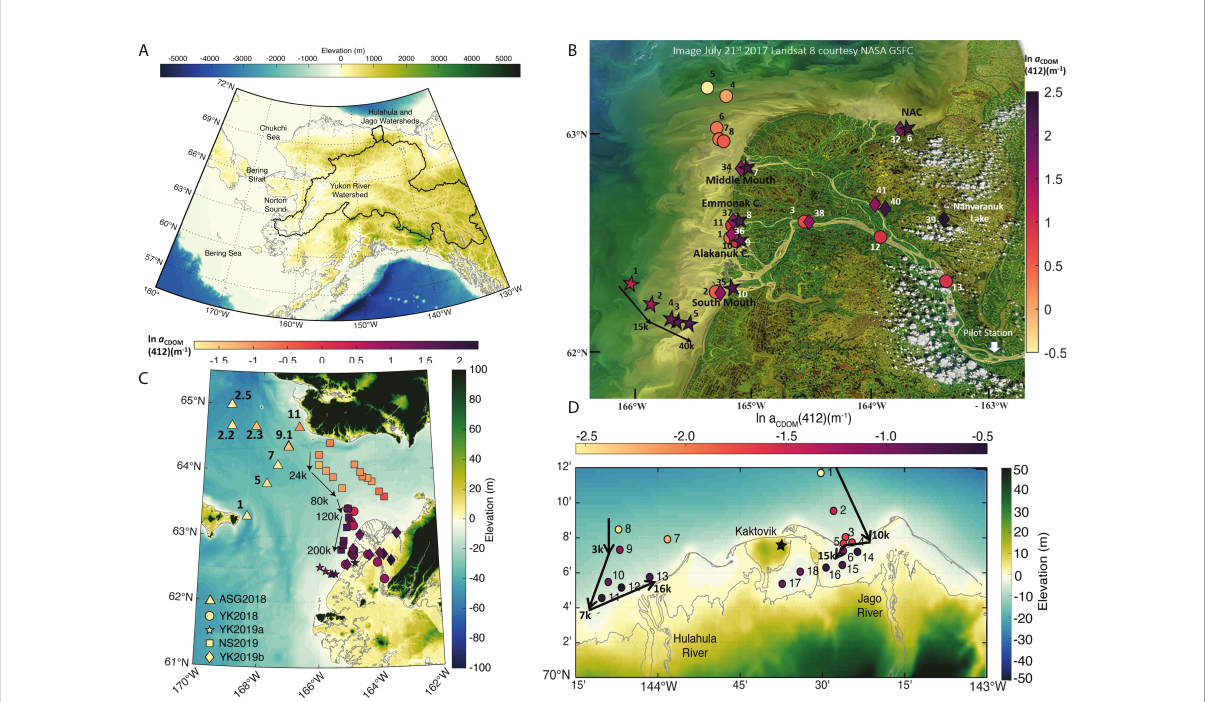
FIGURE 1 (A) Elevation map showing the location of the study regions with the extent of their watersheds outlined in black (B) natural log of CDOM absorption coef fi cient at 412 nanometers (nm) (ln a CDOM (412)(m -1 )) for the Yukon River, delta and plume overlain a Landsat 8 RGB image from July 21 st 2017. The arrows illustrate the direction and distance traveled during the South Mouth transect and correspond to the FDOM cross section depicted in Figure 4A. (C) ln a CDOM (412)(m -1 )) measured 2018 in the Bering Sea and 2019 in the Norton Sound. The arrows show the distance of the Norton Sound transect and correspond to the FDOM cross section shown in Figure 4B. (D) ln a CDOM (412)(m -1 )) from the Kaktovik fi eld deployments on the North Slope. The arrows illustrate the distance traveled during the Jago and Hulahula River transects correspond to the FDOM cross sections depicted in Figures 5A, 5B